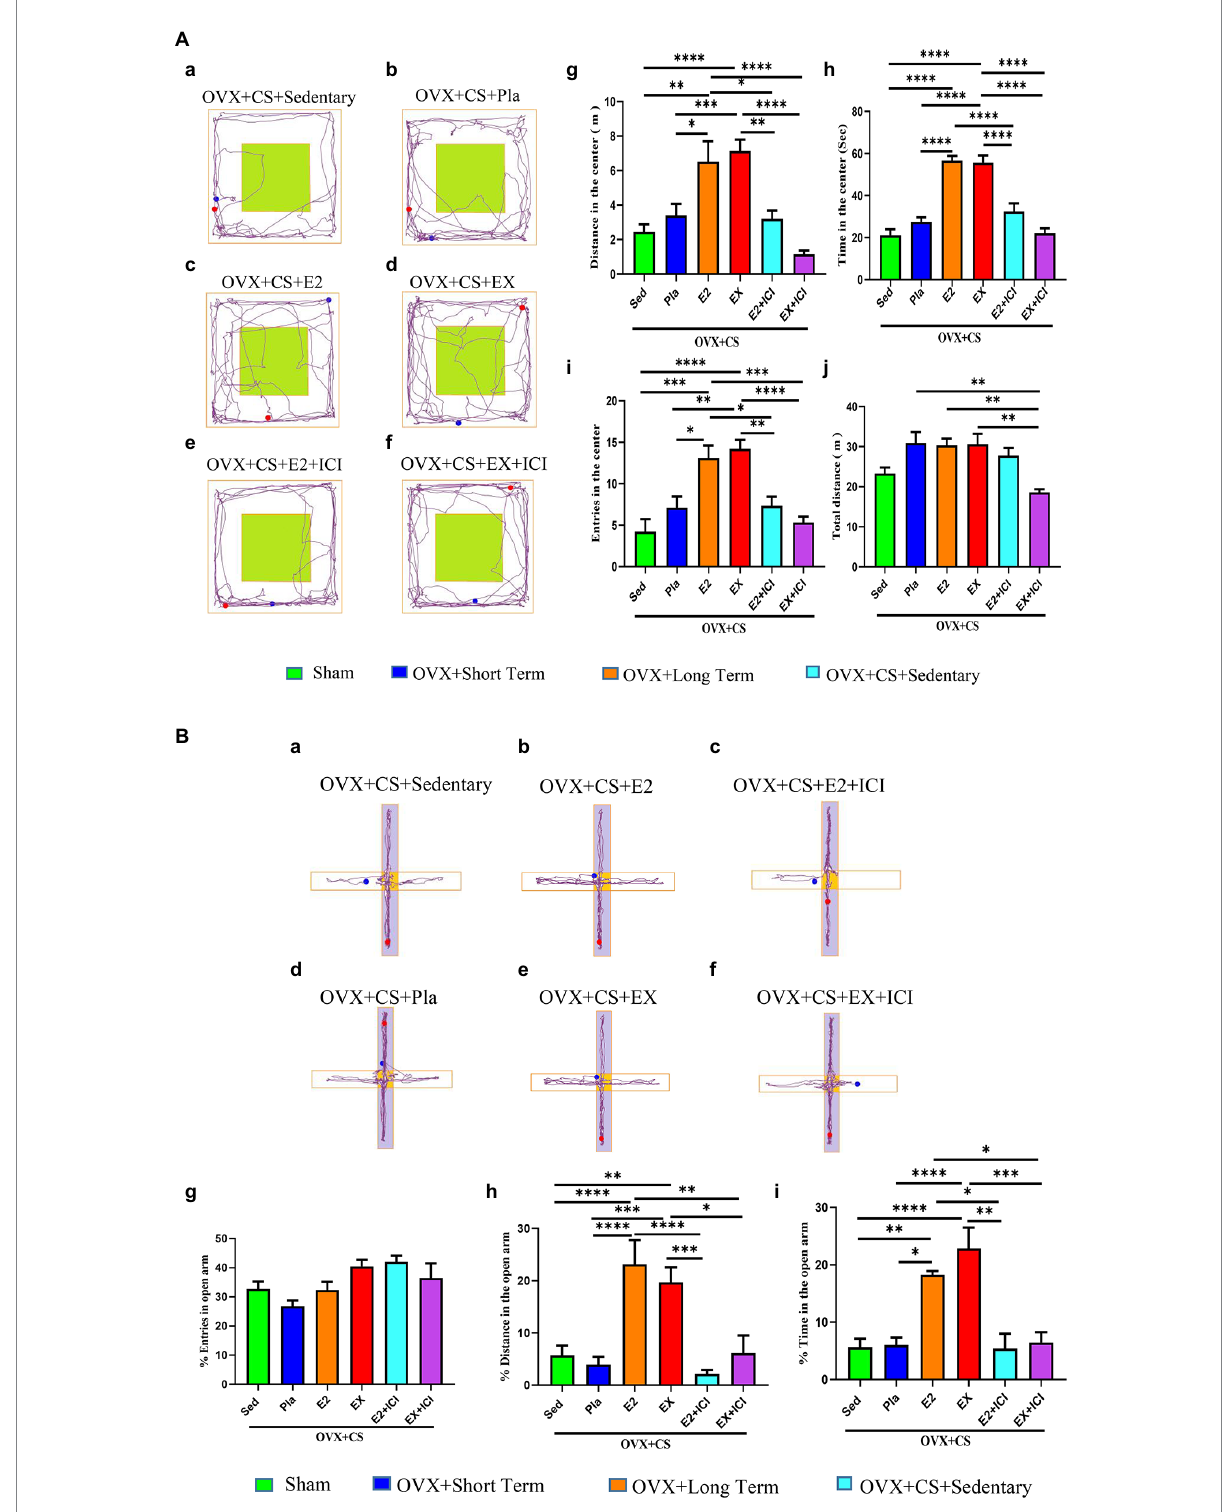
FIGURE 4 Estrogen and aerobic exercise improved the anxiety-like phenotype in depressed rats, but estrogen receptor antagonists blocked the anxiolytic effect of aerobic exercise. (A) Representative plots of activity trajectories of each group of rats in the open field test (a–f) . The activity distance (g) , activity time (h), number of entries (i) and total distance of activity in the open field (j) were analyzed for each group of rats in the central area of the open field. (B) Representative diagrams of the movement trajectories of rats in the elevated cross maze (a–f) . The percentage of times the rat entered the open-arm area (g) , the percentage of distance moved in the open-arm area (h) and the percentage of time spent moving (i) were analyzed. All data are expressed as mean ± SEM ( n = 8–12). * P < 0.05, ** P < 0.05, *** P < 0.001, **** P <